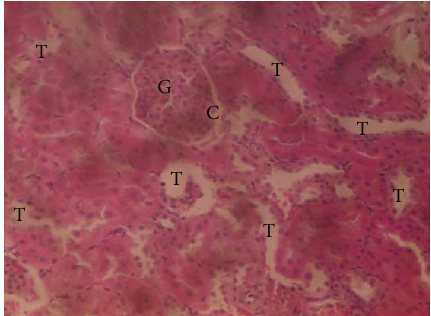
Figure 10: Photomicrographs of the group IV rats with normal kidney.